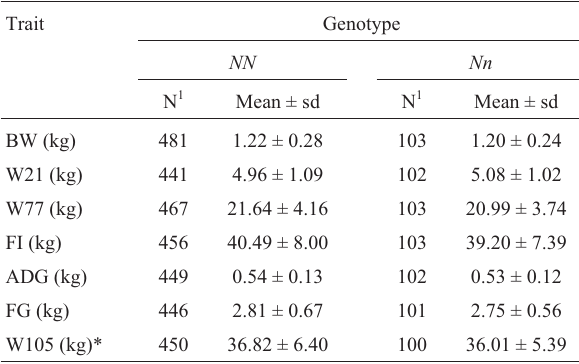
Table 3 - Pig performance traits (means and standard deviations) obtained for each PSS genotypes ( NN and Nn ). Trait